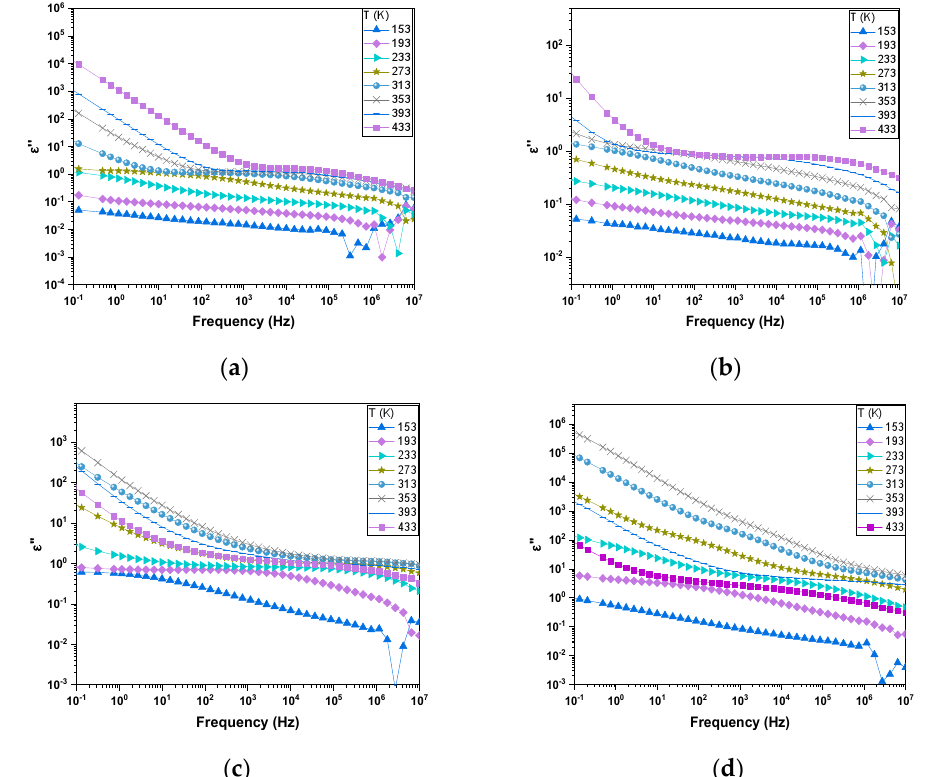
Figure 7. Variations in imaginary part of permittivity with frequency at different temperatures for ( a ) PPDA and PPDA/MMT composites: ( b ) PPDA − 5, ( c ) PPDA − 35 and ( d ) PPDA − 50. To better discuss relaxation processes of the impedance spectra and suppress the electrode polarization effects, the complex dielectric modulus was obtained from the real and imaginary part of the permittivity.